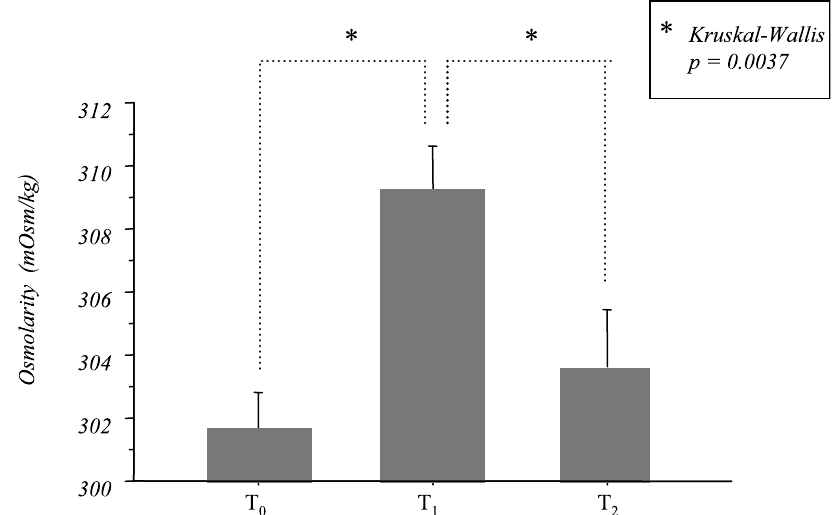
FIG. 2. Transient increase in serum osmolarity after iopromide infusion. T 0 , sample taken before the initiation of the procedure; T 1 , sample taken 5 min after infusion of RCM; T 2 , sample taken 60 min after the infusion of RCM. * Statistically significant differences (p B /